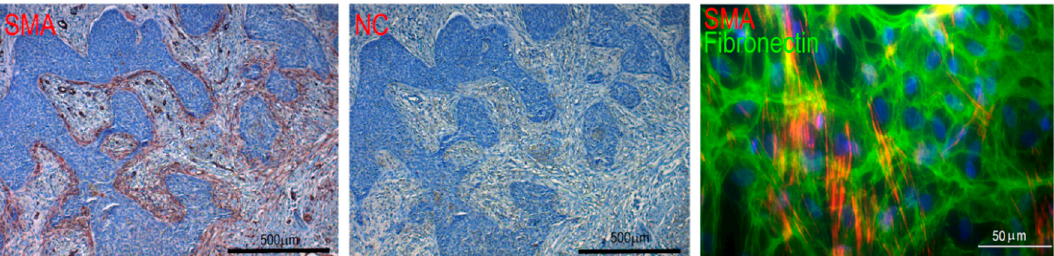
Figure 2. Expression of α -smooth muscle actin (SMA) in basal cell carcinoma and CAF. The figure demonstrates SMA-positive stroma (red) and negative control (NC). Cultured CAF from the human basal cell carcinoma visualised by detection of α -smooth muscle actin (red signal) in the extracellular matrix rich in fibronectin (green signal). Nuclei are counterstained by DAPI (blue signal). The bar represents 500 and 50 μ m, respectively. Specimens were prepared in the authors’ laboratory.